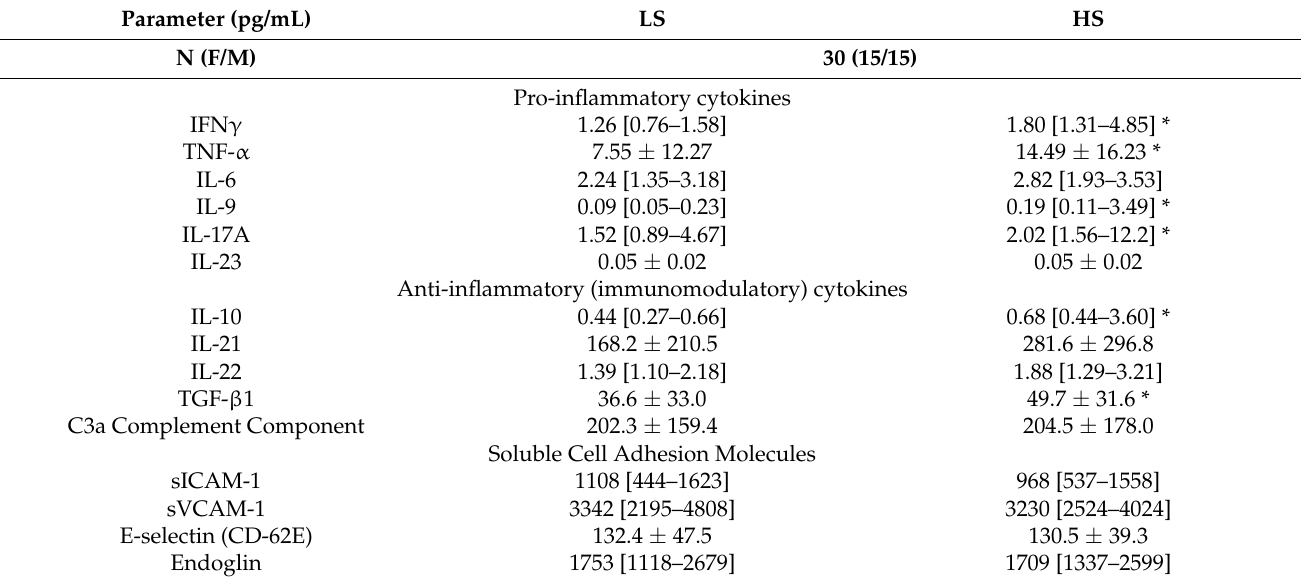
Table 2. Serum protein concentration of pro- and anti-inflammatory cytokines, C3a complement component, soluble cell adhesion molecules, and endoglin responses to a 7-day high-salt diet in healthy young